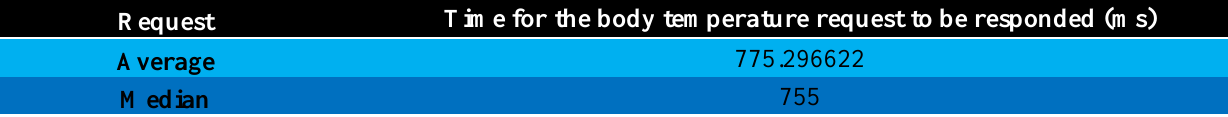
Table 5. Most significant measures obtained for body temperature service.